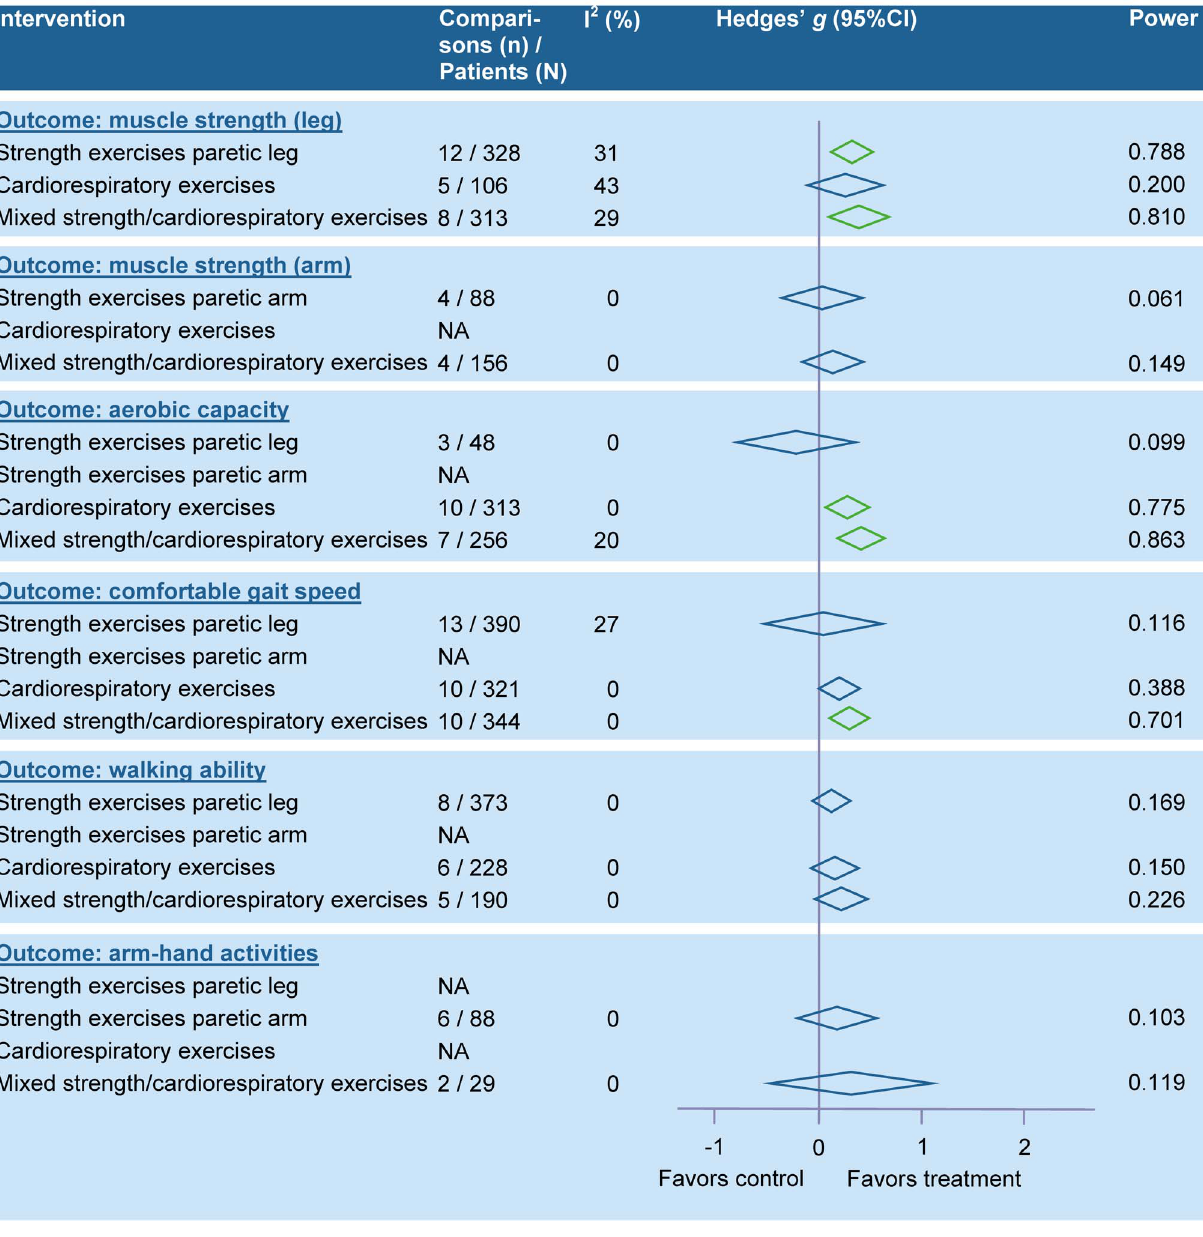
Figure 4. Summary effect sizes for physical therapy interventions – physical fitness. Legend: A green colored diamond indicates that the summary effect size is significant, while a blue colored diamond indicates that the summary effect size is nonsignificant; CI, Confidence interval; NA, Not applicable.